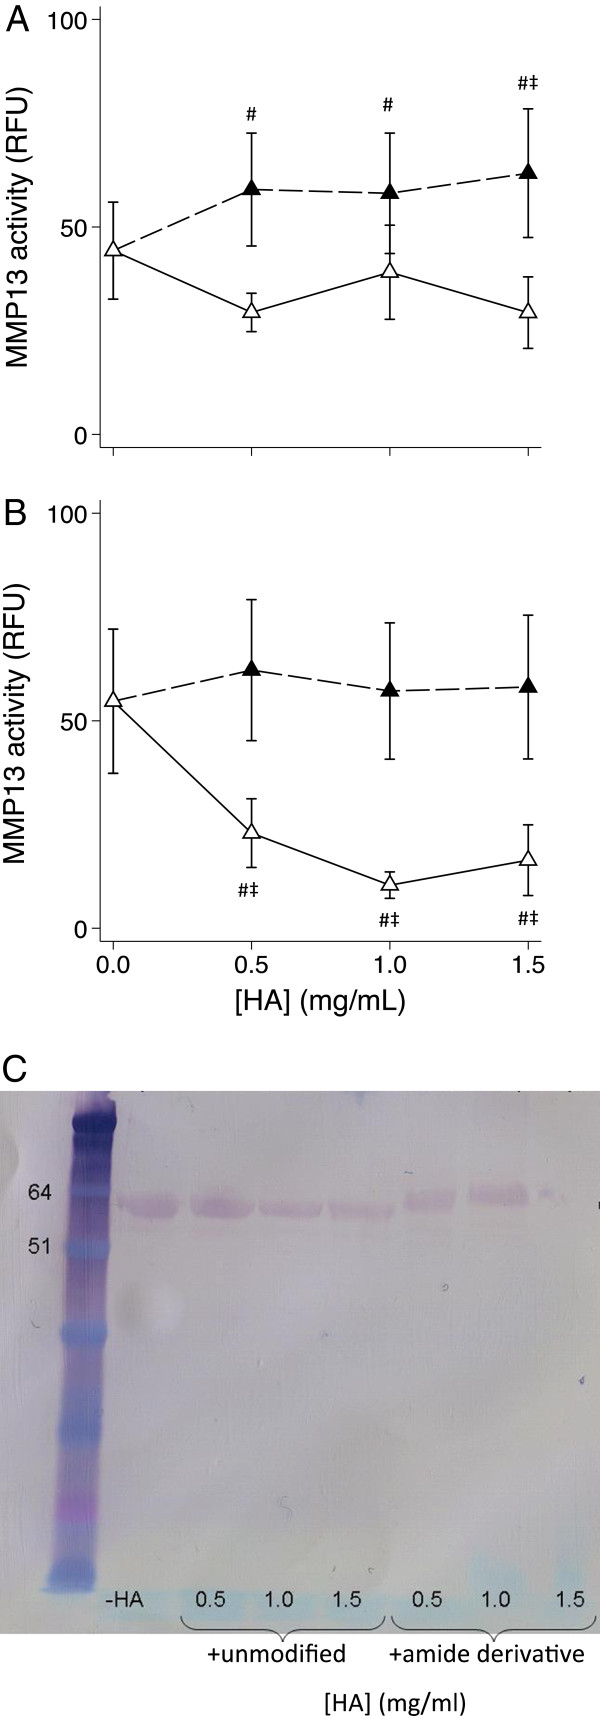
HA dose response on MMP-13 activity and protein. Dose response of the effect of unmodified HA (black) or the hexadecylamide derivative of HA (white) on APMA-activated MMP13 activity in the culture media after exposure to IL-1β (2 ng/mL) for 24 hours in HSF (A) or HAC (B). P < 0.05 # different from IL-1, no HA control; ‡ different between the amide derivative and unmodified HA at the same concentration. (C) Western blot of MMP-13 protein in pooled media from HAC incubated with and without unmodified or the hexadecylamide derivative of HA at the indicated concentrations. Migration of pre-stained molecular mass markers (kDa) is shown on the left.